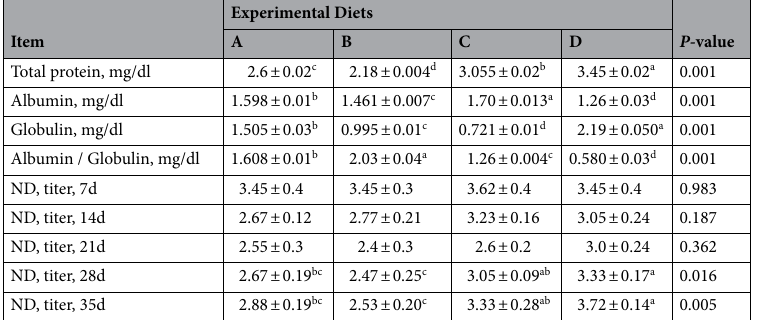
Table 6. Effect of DETOXIZYME supplementation on immunity under clostridia infection in Cobb 500 broilers. a–c The means values placed at the rows by different superscript letters are significantly different (P < 0.05). Values are expressed as means ± standard error. Abbreviations: (A) control negative (basal diet), (B) control positive (basal diet supplemented with clostridia infection), (C) control positive group diet with 100 g DETOXIZYME/ton of feed, (D) control negative diet group with 100 g DETOXIZYME/ton of